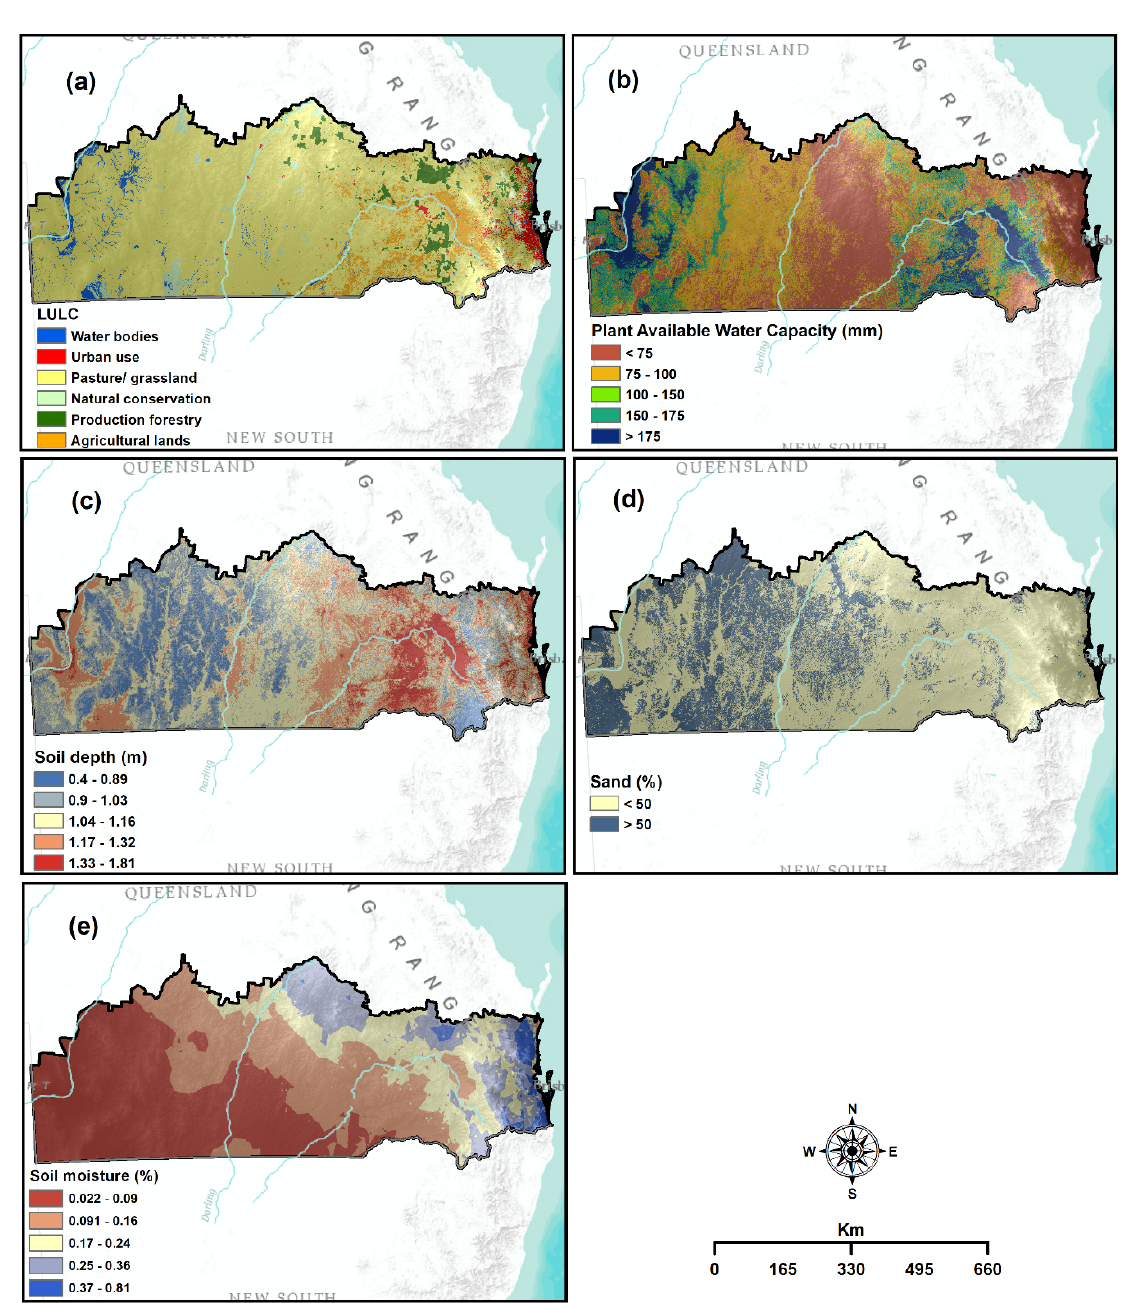
Figure 5. Thematic layers used for agricultural drought vulnerability: ( a ) LULC; ( b ) PAWC; ( c ) soil depth; ( d ) sand percentage; and ( e ) soil moisture.